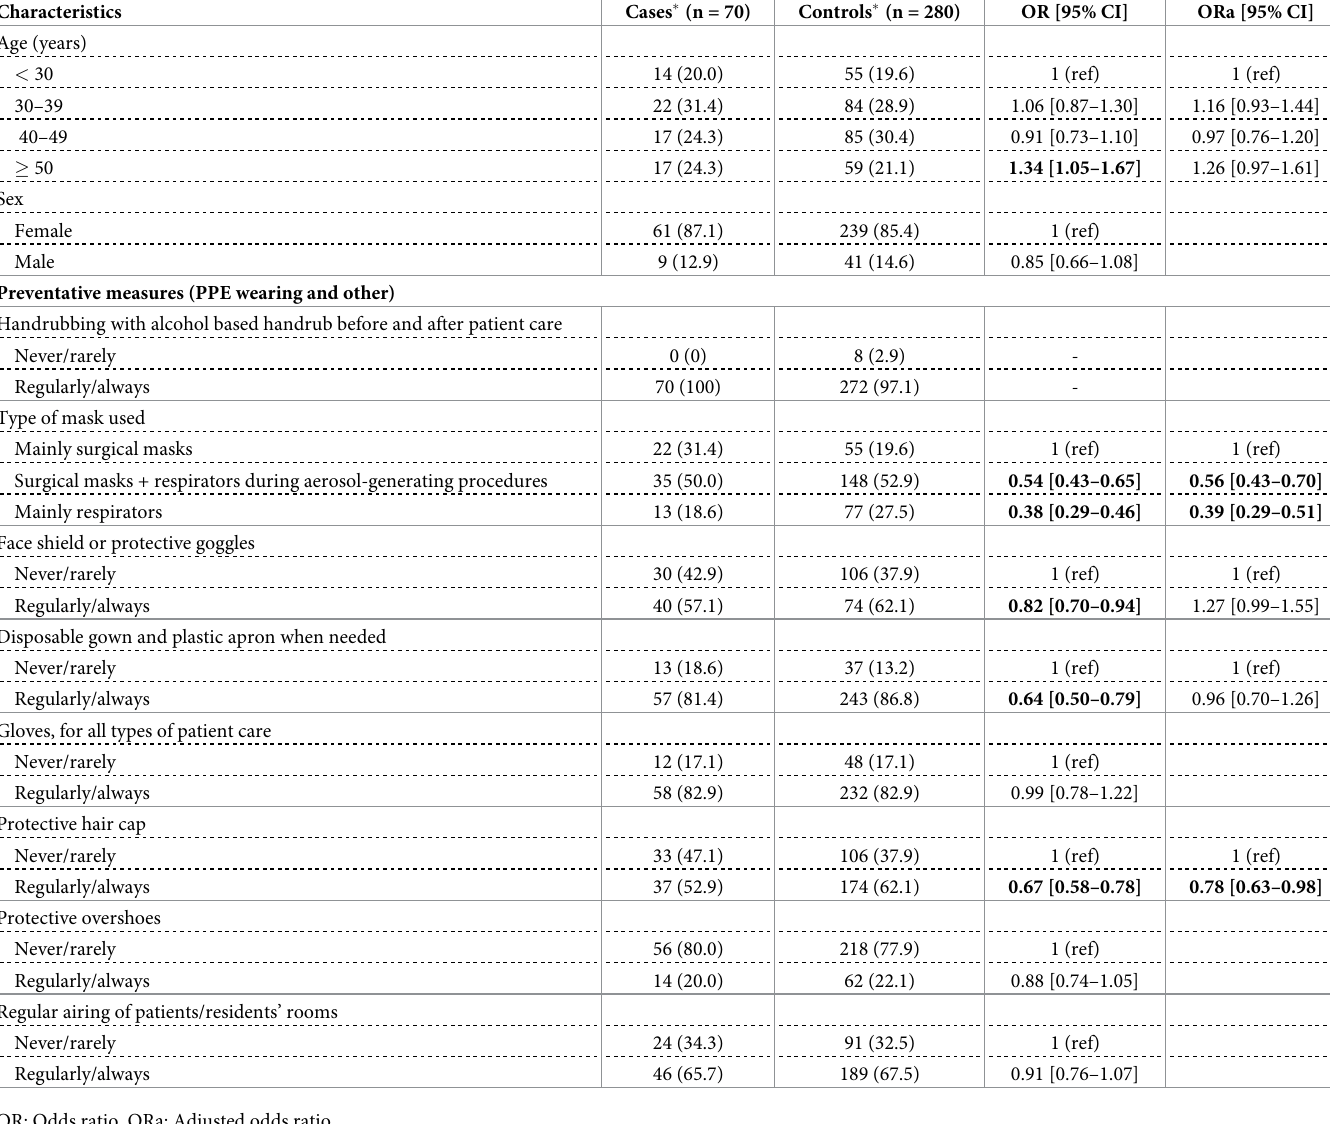
Table 2. Case-control study 1: Exposures associated with risk of COVID-19 among HCWs caring for COVID-19 patients.